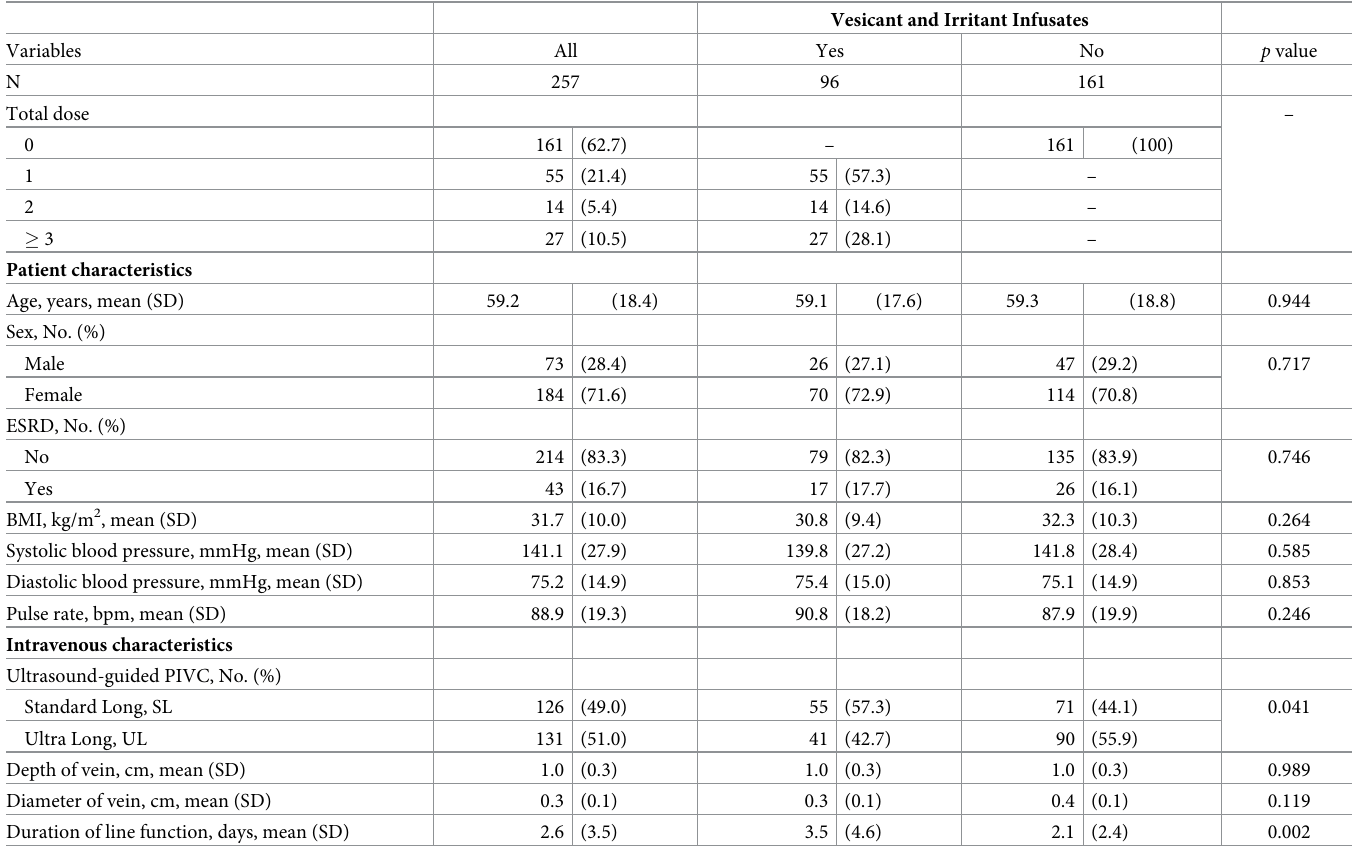
Table 1. Patient and intravenous-related characteristics stratified by use of vesicant and irritant infusates.